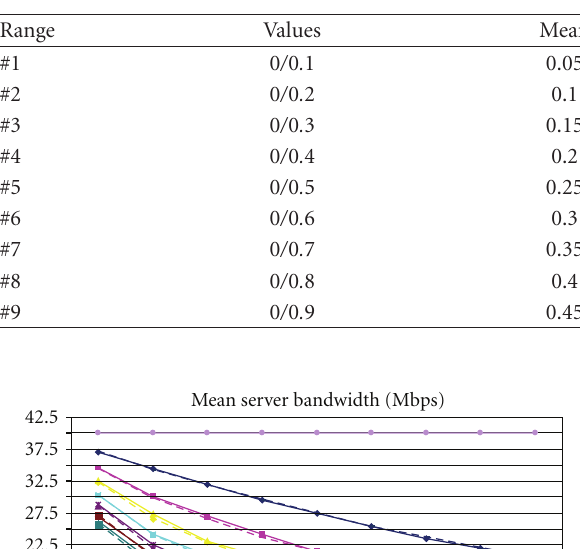
Table 1: Ranges of the uniform distribution for the probability Q of the GE model.